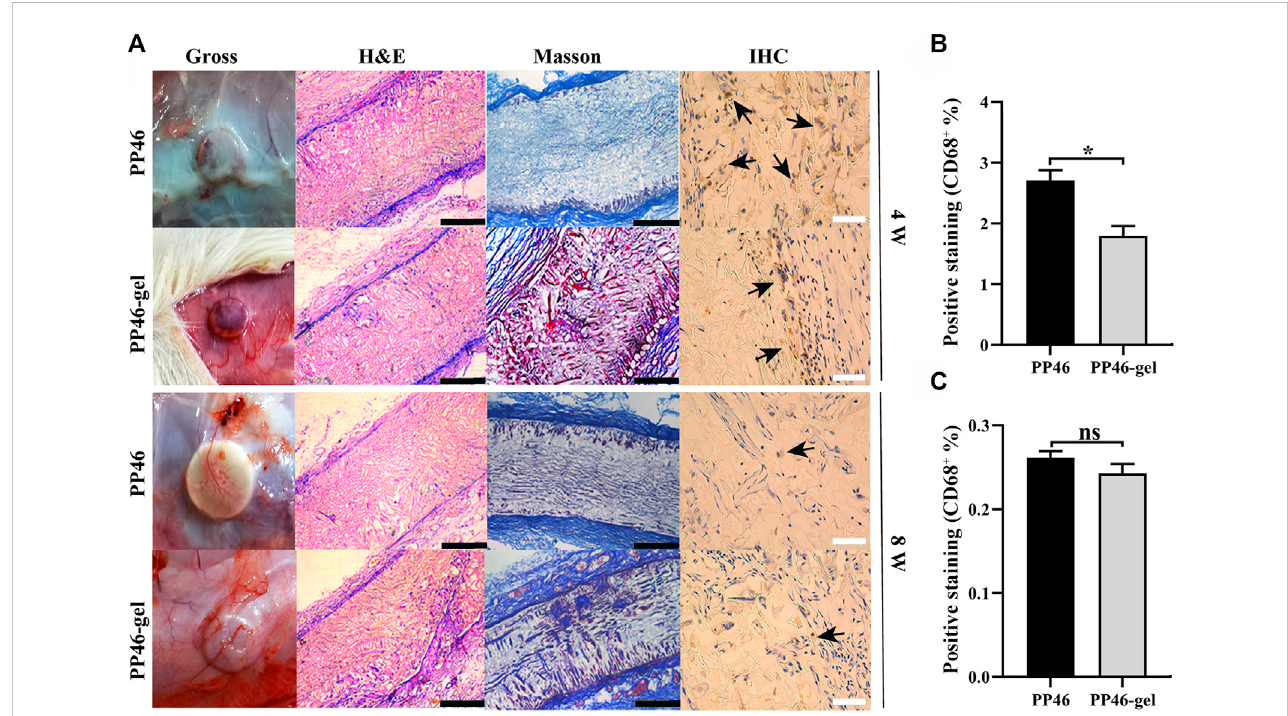
FIGURE 4 Histological analysis. (A) Scaffolds were implanted subcutaneously in SD rats for 4 and 8 weeks. Black arrows indicate CD68 + cells. (B, C) Quantitative analysis of the CD68 + ratio from IHC analysis. Scale bar, 400 μ m (black) or 100 μ m (white). Data are presented as mean ± SD (ns: p > 0.05; * p <